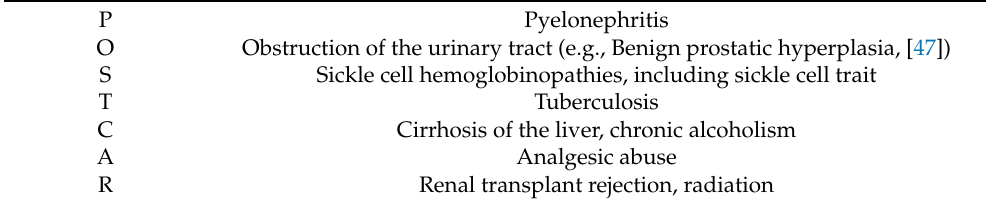
Table 1. The mnemonic for renal papillary necrosis (RPN) is “POSTCARDS”. P Pyelonephritis O Obstruction of the urinary tract (e.g., Benign prostatic hyperplasia, [47]) S Sickle cell hemoglobinopathies, including sickle cell trait T Tuberculosis C Cirrhosis of the liver, chronic alcoholism A Analgesic abuse R Renal transplant rejection,